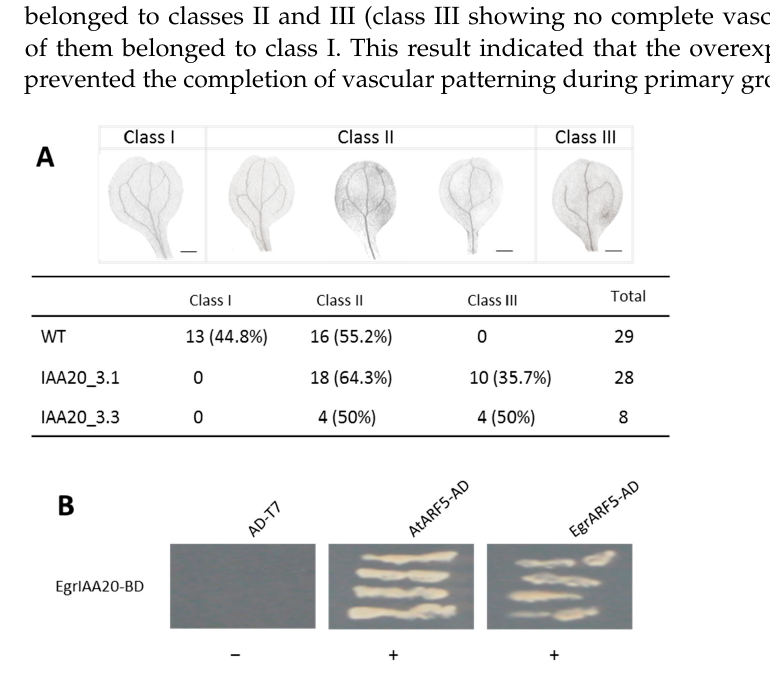
Figure 6. Over-expressing EgrIAA20 in Arabidopsis regulated vascular patterning in cotyledons through the interaction with AtARF5. ( A ) EgrIAA20 overexpression impaired vascular patterning in cotyledons. The vascular patterning was assessed by the number of secondary vein loops originating from the mid-vein. Class I presents four complete vascular loops; class II presents partially incomplete venation with at least two loops; class III presents entirely incompletely venation with no entire venation loop. In wild type seedlings, all the cotyledon venation patterns belonged to classes I and II, and 45% of them exhibited a more complex pattern (class I with four complete loops). In contrast, cotyledon venation patterns of all the transgenic plants belonged to classes II and III; none of them showed the complete vascular patterning with four loops (class I). Values in bracket indicate the percentage contribution of each class. The scale bars represent 0.5 mm. ( B ) EgrIAA20 interacts with Arabidopsis ARF5/MP (AtARF5) and its potential ortholog in Eucalyptus EgrARF5 in yeast-2- hybrid assay. The EgrIAA20 and AtARF/EgrARF5 proteins were fused with GAL4 DNA-binding domain (BD) and a GAL4 activation domain (AD), respectively. Yeast of co-transformed EgrIAA20-BD and AtARF5-AD or EgrARF5-AD grew on quadruple dropout medium lacking leucine, tryptophan, histidine, and adenine (THLA), and then scratched again on a TLHA plate; AD-T7 were used as negative